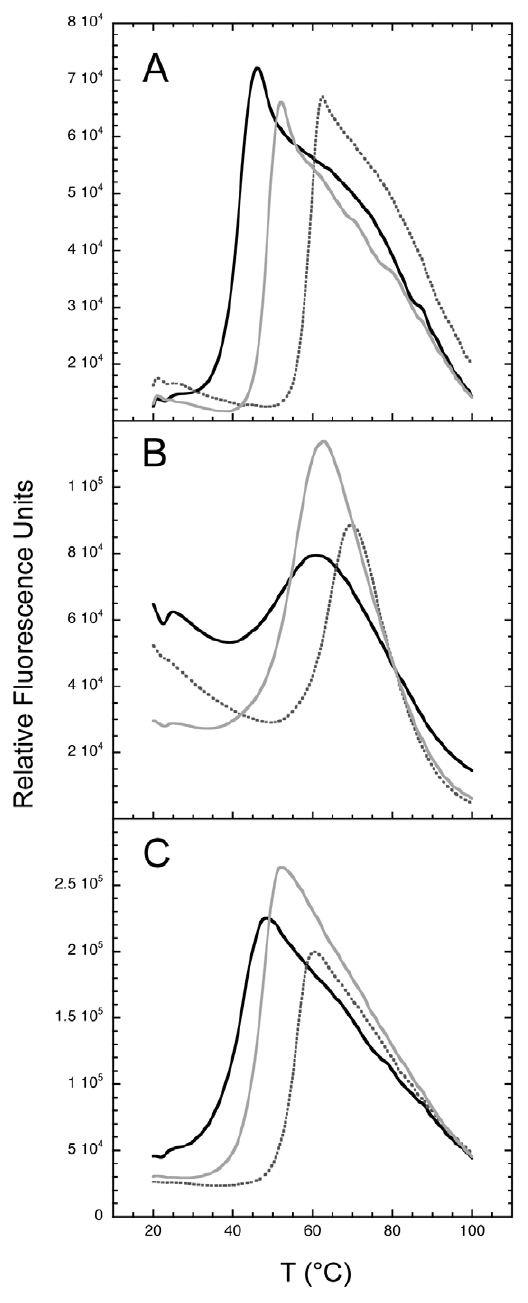
Figure 5. Thermal denaturation of EngA, GD1 and GD2-KH and protective effects of nucleotides. The denaturation of EngA ( A ), GD1 ( B ) and GD2-KH ( C ) was monitored by the Thermal Shift Assay in the absence (plain black lines) or in the presence of 1 mM GMPPNP (plain grey lines) or 1 mM GDP (dotted grey lines).